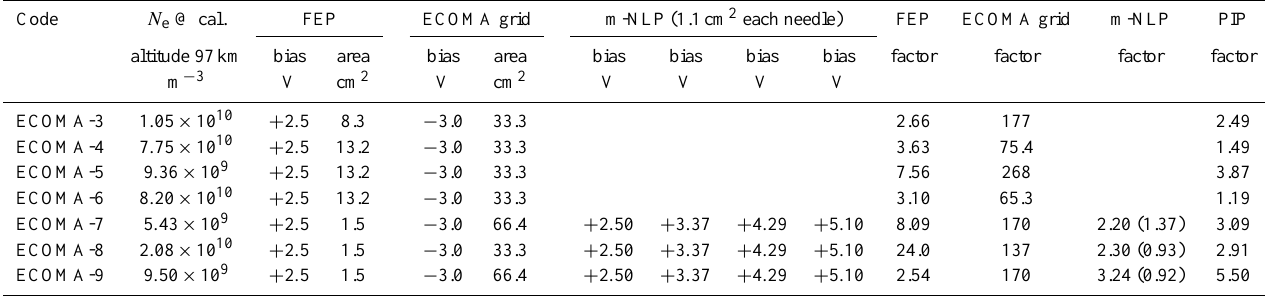
Table 2. List of ECOMA flights with technical data of the various probes. In the last four columns, the deviation factors are given by which the nominal probe results have to be reduced for agreement with the respective wave propagation electron densities at 97km on upleg. The values in brackets apply when using the minima in a spin period (see